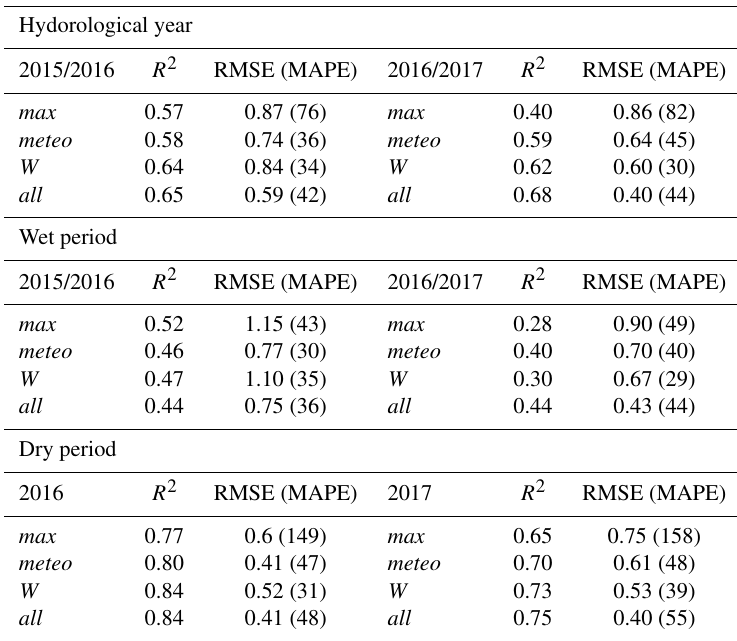
Table 1. R 2 , RMSE (gm − 2 ) and MAPE (%) obtained by comparison with EC measurements for 2015/2016 and 2016/2017 in the four methods, and over wet and dry periods.